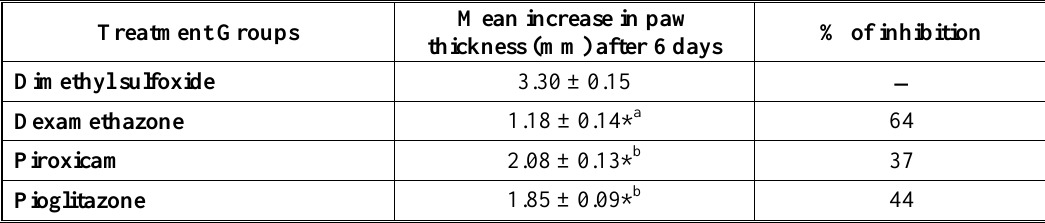
Data were expressed as mean ± SEM; number of animals = 6 in each group; P < 0.05 with respect to control group; values with non-identical subscription (a, b) are considered significantly different ( P